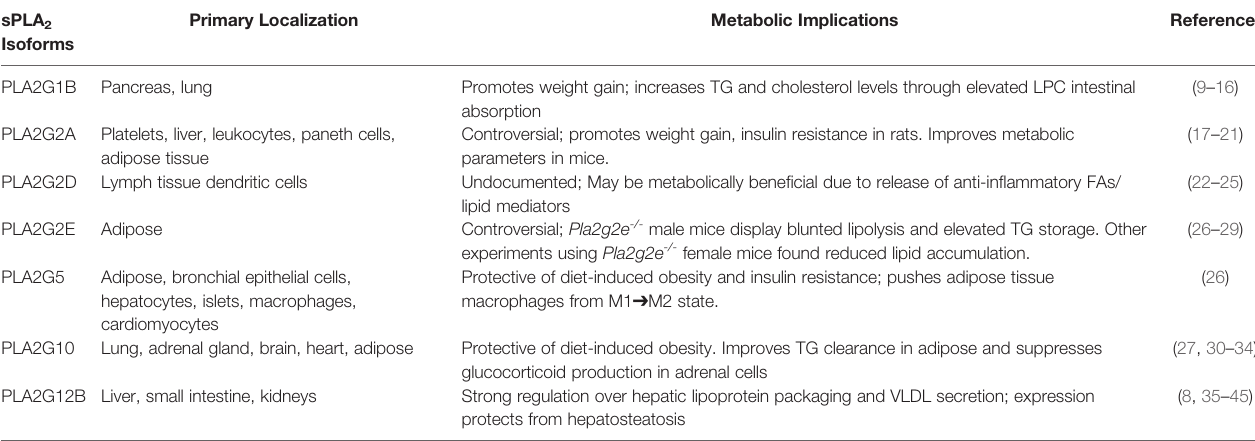
TABLE 1 | Metabolic roles of sPLA2